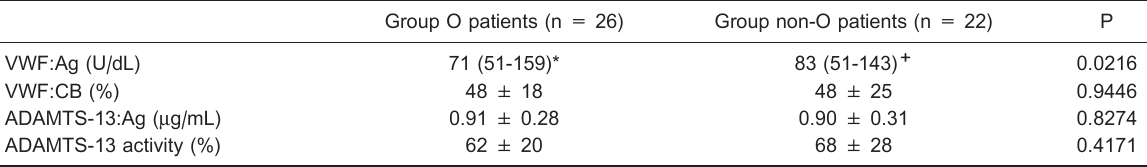
Table 2. Comparisons of VWF and ADAMTS-13 levels in patients according to ABO blood groups.